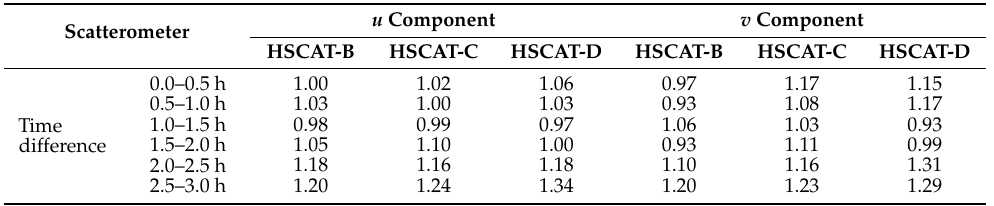
Table 4. Time-dependent observation-to-background error